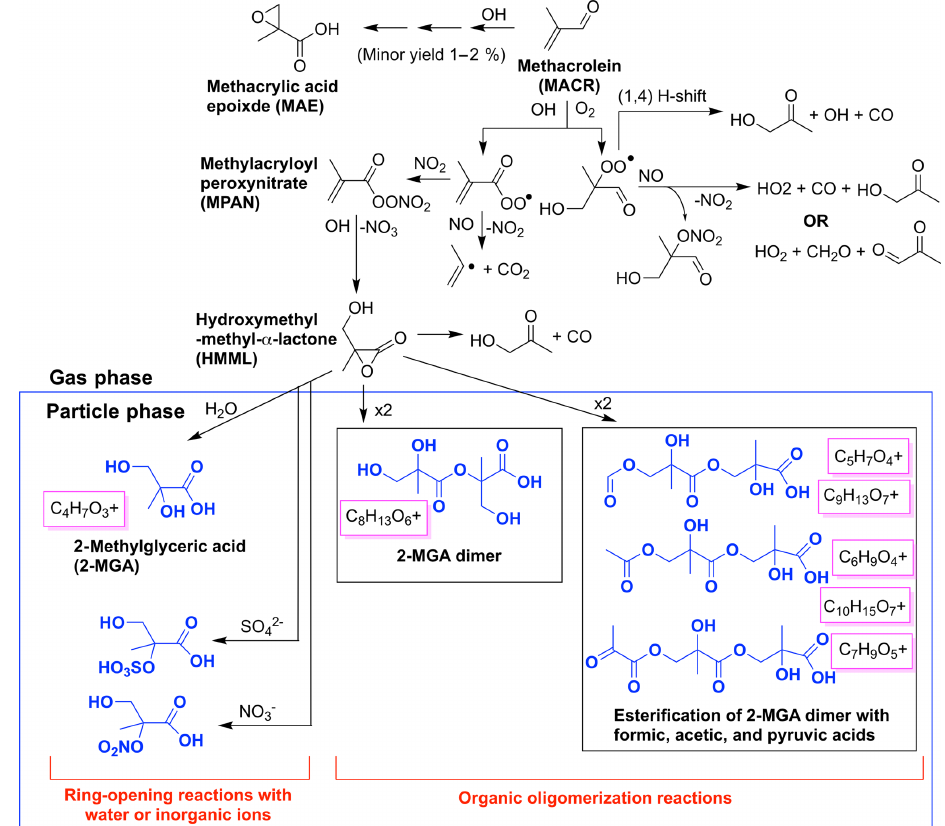
Figure 2. Simplified chemical mechanism of methacrolein OH-initiated oxidation under high-NO 2 conditions, largely based on schemes in Wennberg et al. (2018), emphasizing SOA generated from the 2MGA pathway including 2-methyl glyceric acid (2-MGA) and its oligomers in blue. Aerosol mass spectrometer (AMS) fragments likely corresponding to each compound are boxed in